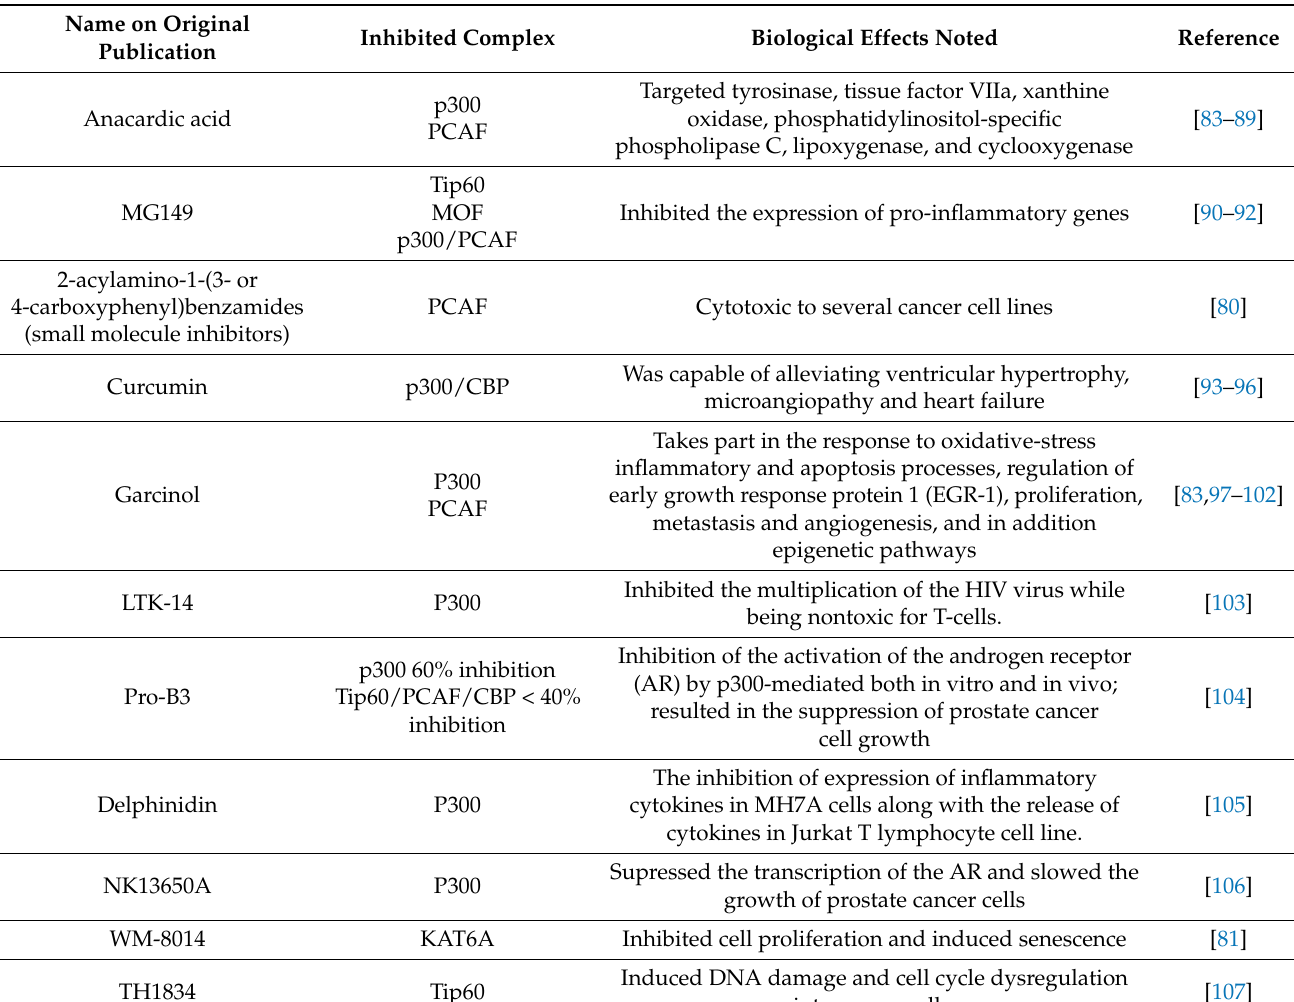
Table 1. List of KAT inhibitors with known effects on human